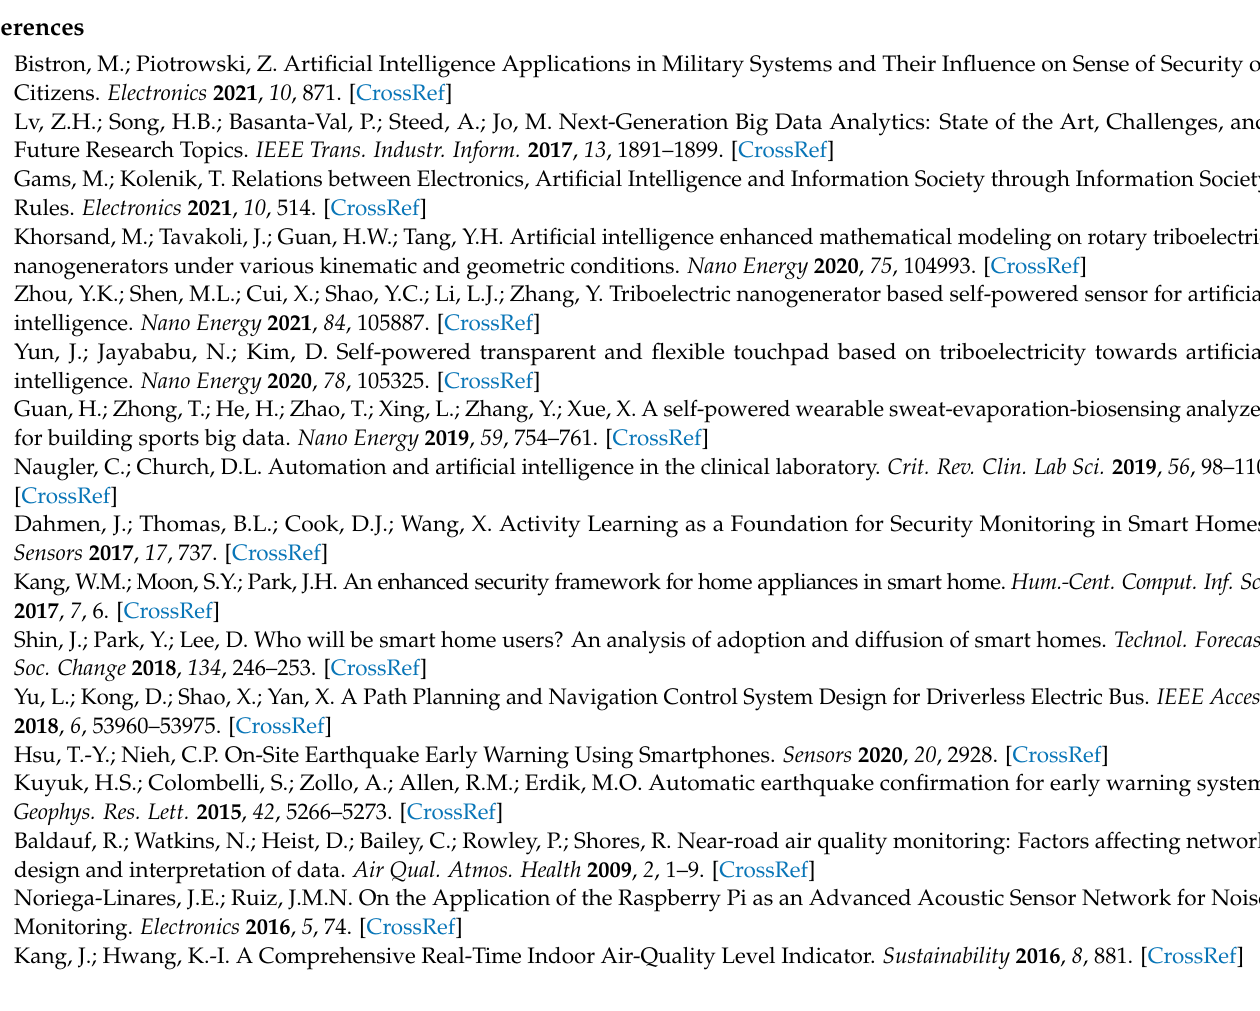
tographs. Figure S2. The frequency test scenario photographs. Figure S3: The circuit of unsports- manlike action monitoring system. Video S1: Test of dot LED lamp for hydrogel electrode device and copper electrode device. Video S2: Wireless Bluetooth transmission system. Video S3: Turning kick test for male athletes. Video S4: Turning kick test for female athletes. Video S5: Male athlete 360 ◦ turning kick test. Video S6: Female athlete 360 ◦ turning kick test. Video S7: Back kick, side kick, and turning kick proficiency test for female athletes. Video S8: Test of unsportsmanlike action monitoring